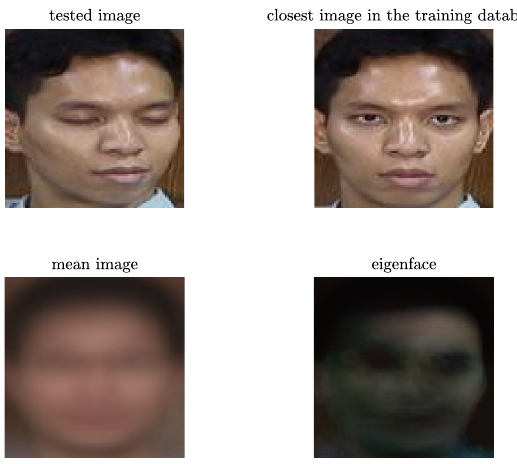
Figure 6. Test image, closest image, mean image and eigenface.